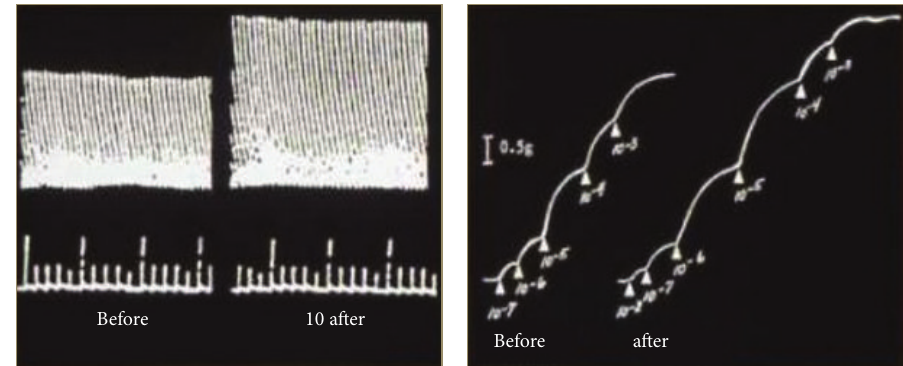
10 after Before after Before Figure 4: Representative original polygraph tracings of chicken biventer cervicis nerve-muscle preparation (in Krebs-Henseleit solution aerated with 95% O 2 /5% CO 2 ) in response to electrical stimulation of fast twitch fibers and contraction to exogenous acetylcholine (slow musclefibers)inthepresence(after)andabsence(before)ofpooledimmunoglobulinfraction(21daysafterPSPadministration).Thissuggests that these serum immunoglobulins may alter neuromuscular function.